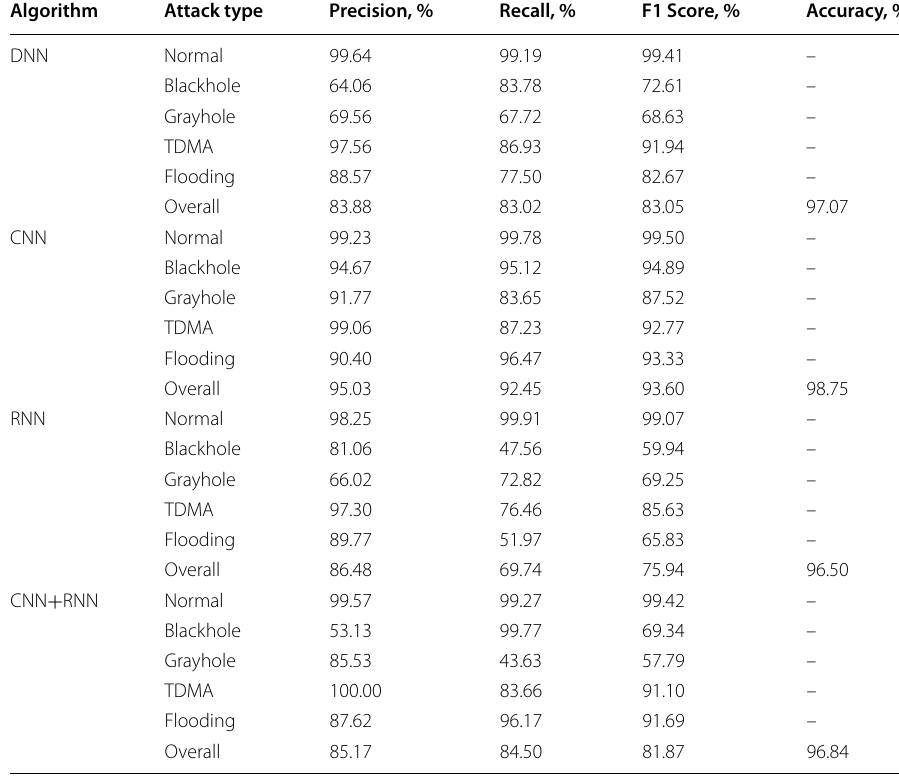
Table 8 Performance of each algorithm on training data